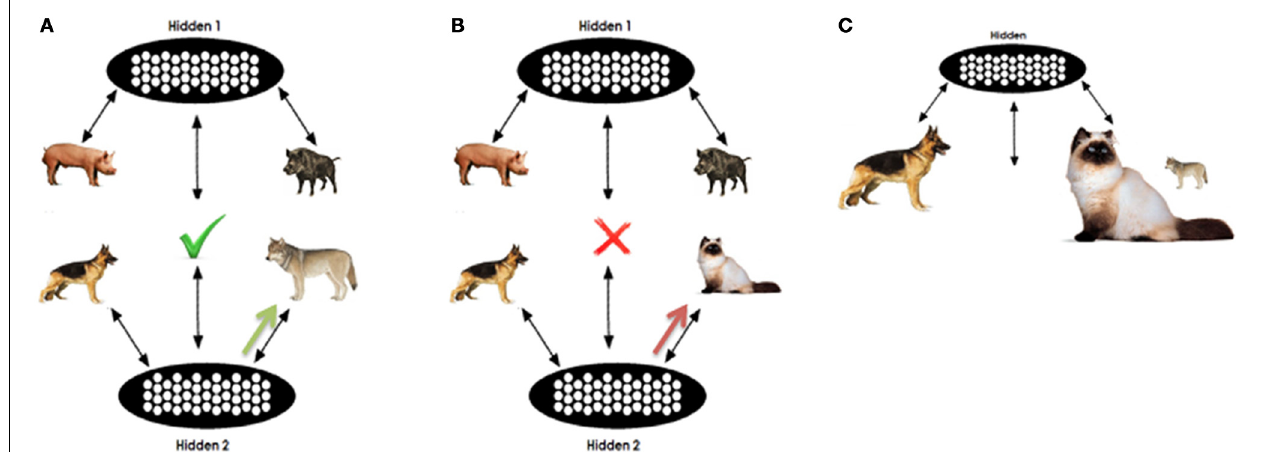
FIGURE 3 | Illustrative analogy question. (A,B) Sketch analogy testing in the question PIG:BOAR::DOG:[WOLF|CAT]. The concept WOLF will initially support consistent pattern completion in the R pool. When unclampled, the partially completed pattern will support residual